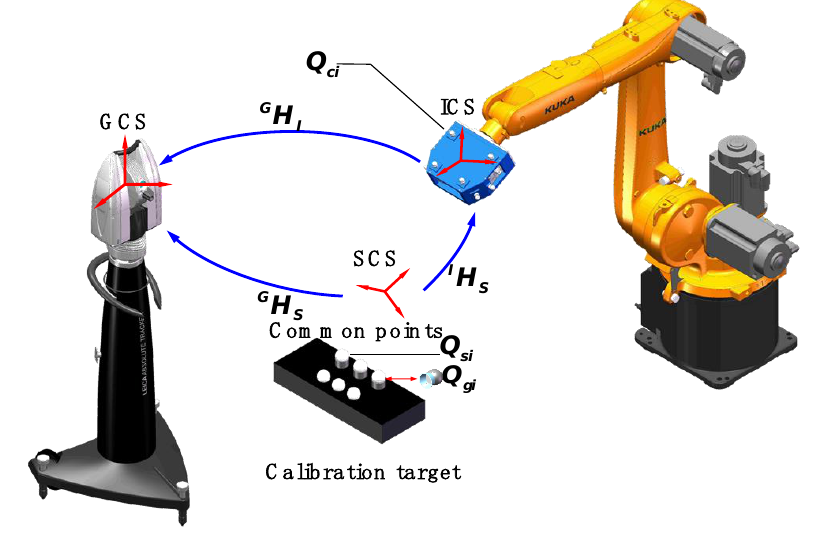
Figure 3. Principle of extrinsic parameter calibration.